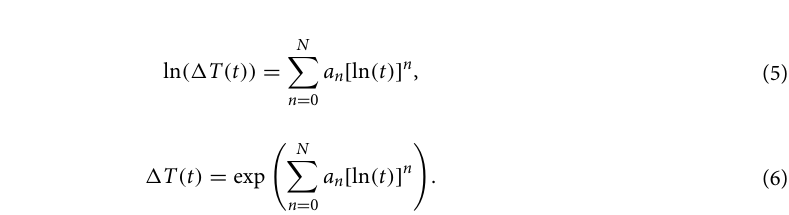
Figure 9. Detail from the “Monocromo”: a root of a tree. From left to right: visible, TQR and the light-balanced TQR obtained with the anisotropic osmosis